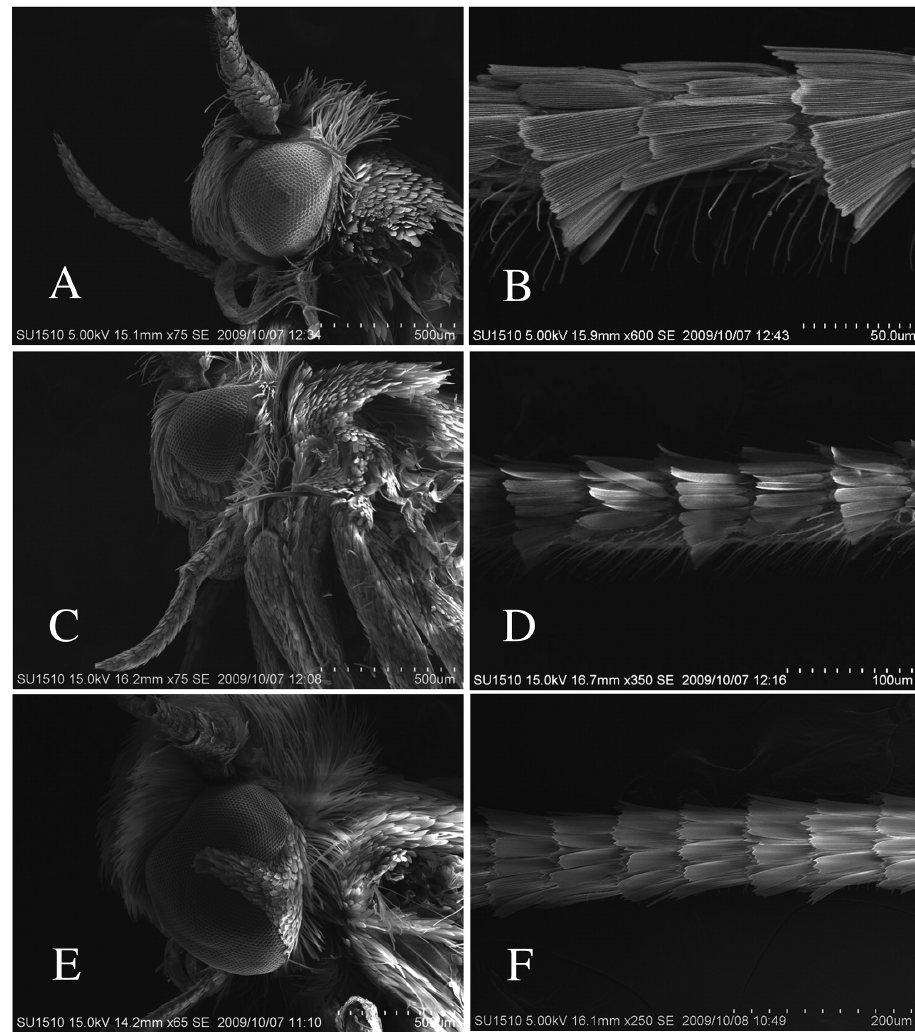
Figure 7. SEM images of head and antenna in Roeslerstammidae. A–B Roeslerstammia tianpingshana sp. n., male C–D R. pronubella male, Japan. E–F Telethera blepharacma Meyrick, 1913, male, Japan. A, C, E Lateral aspect of the head B, D, F Antenna, lateral